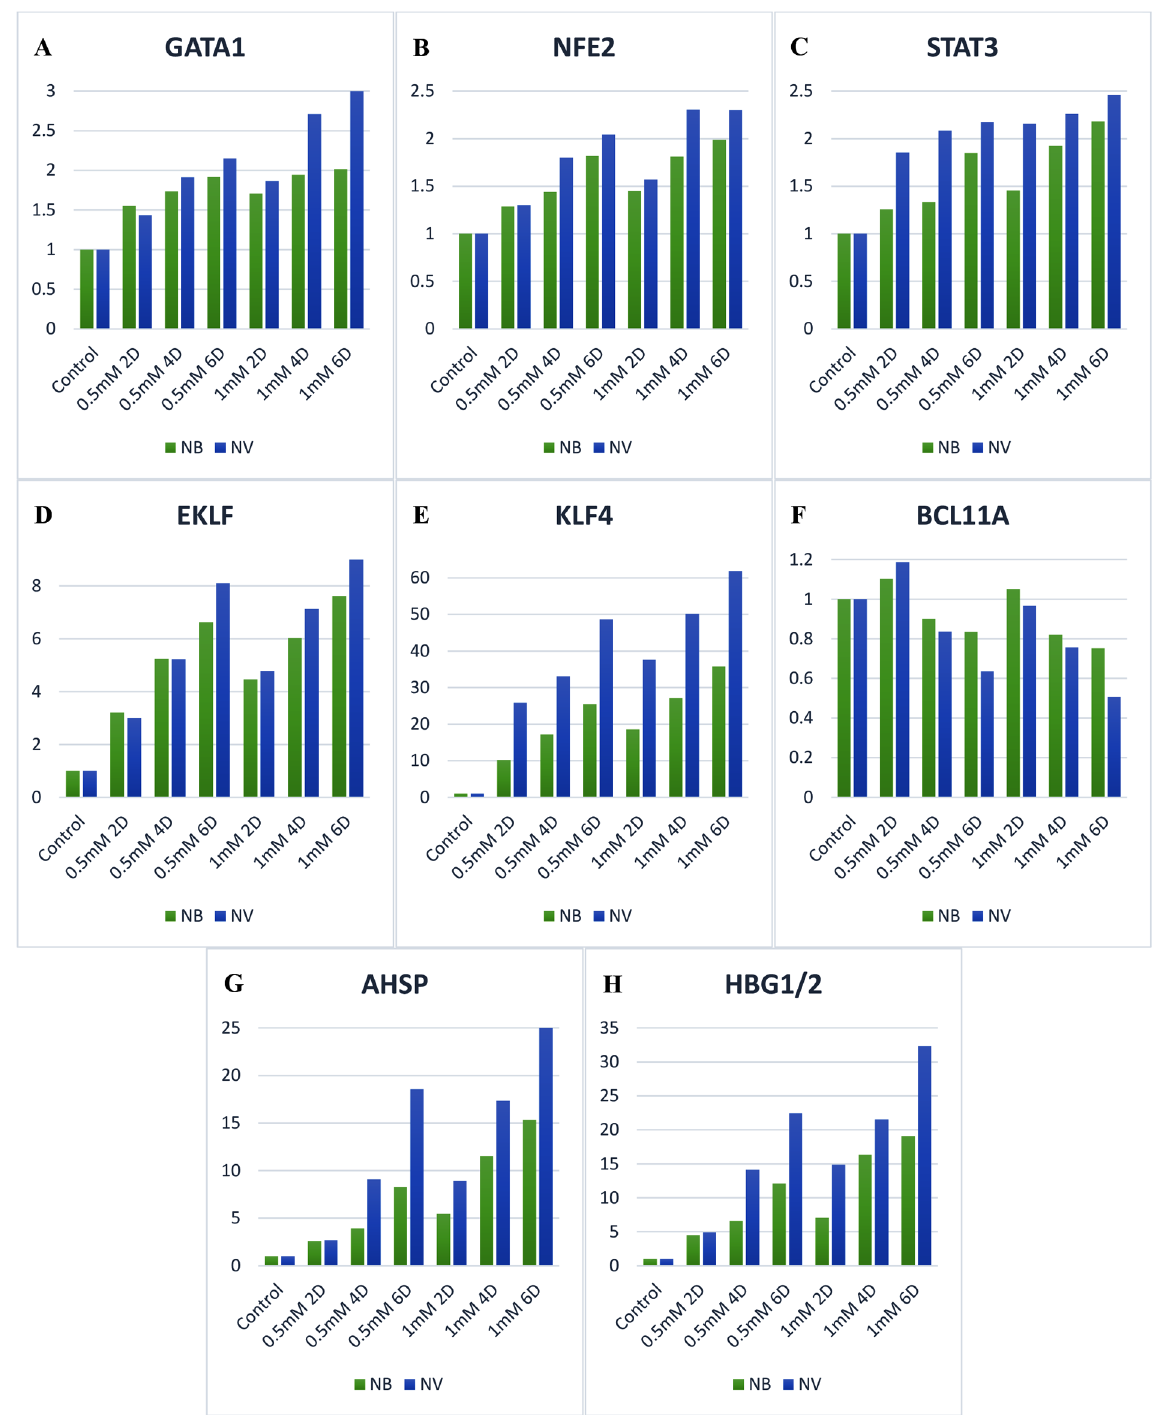
Fig 1. The effect of sodium phenylbutyrate and sodium valproate on the expression of AHSP, BCL11A, γ -globin genes (HBG 1/2) and erythroid transcription factors. Both compounds led to significant induction of AHSP, γ -globin genes (HBG1/2) and erythroid transcription factors in K562 cells ( p < 0.05). However, BCL11A was significantly repressed due to treatment with them ( p < 0.05). Higher concentrations of the studied HDIs and longer treatment times led to significantly greater repression of BCL11A and higher expression of other target genes ( p < 0.0005). NB, sodium phenylbutyrate; NV, sodium valproate; 2D, two days of treatment; 4D, four days of treatment; 6D, six days of treatment.